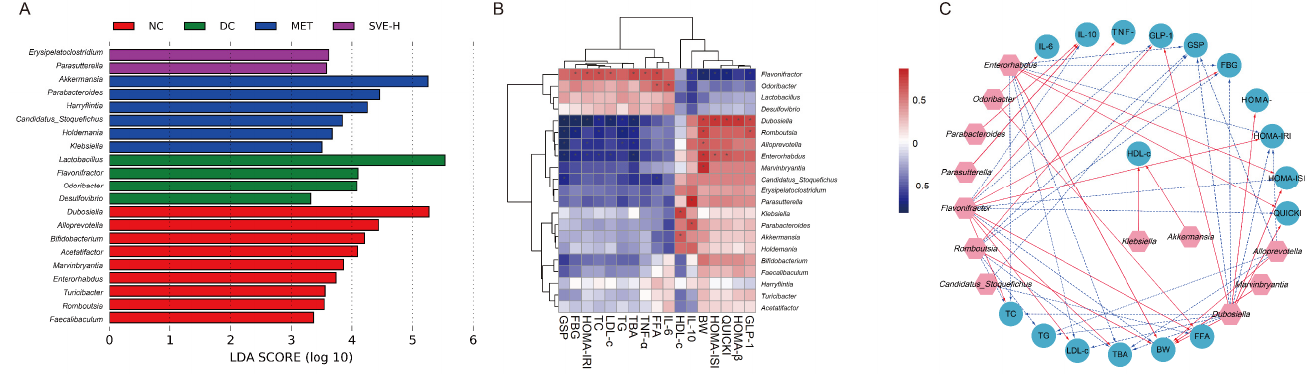
Figure 6. LEfSe analysis of gut microbiota at genus-level among NC, DC, MET, and SVE-H groups ( A ). Heatmap of correlations between the significant different gut microbiota and physiological/biochemical parameters ( B ). Visualization of the correlation network. Note: pink nodes: gut microbial genera; cyan nodes: parameters; red lines: Spearman’s rank correlation coefficient >0.6, adjusted p < 0.01; blue lines: Spearman’s rank correlation coefficient < − 0.6, adjusted p < 0.01; the linewidth indicates the strength of correlation ( C